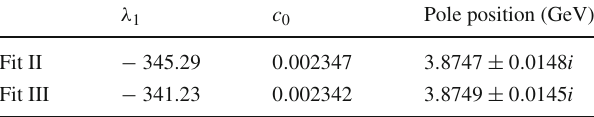
Table 1 The parameters which determine the pole positions of Fit II and Fit